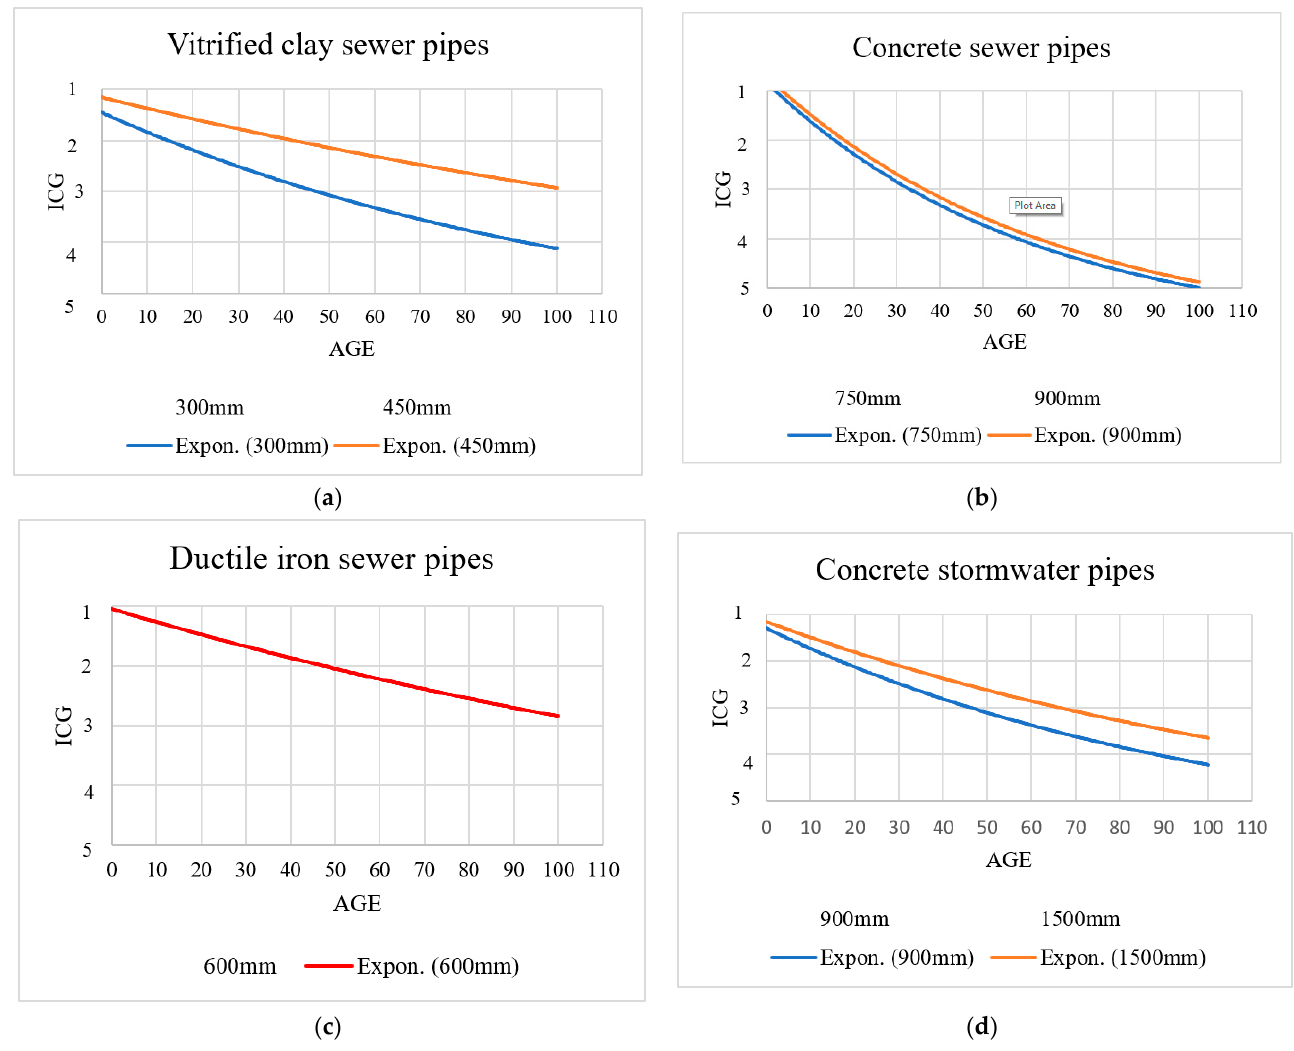
Figure 5. Sensitivity analysis. ( a ) Vitrified clay sewer pipes. ( b ) Concrete sewer pipes. ( c ) Ductile iron sewer pipes. ( d ) Concrete stormwater pipes.